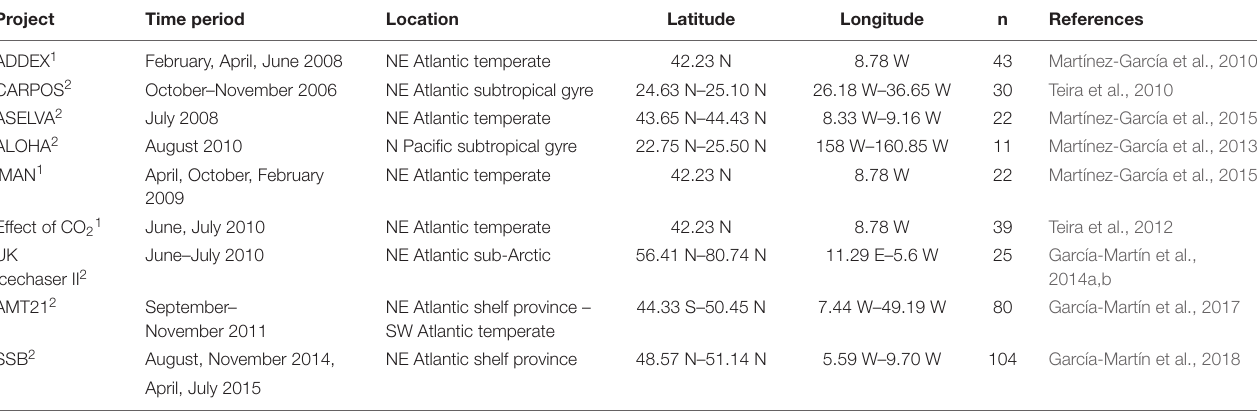
TABLE 1 | Description of the project, time of the year, location, number of data points (n) and references of the different projects.